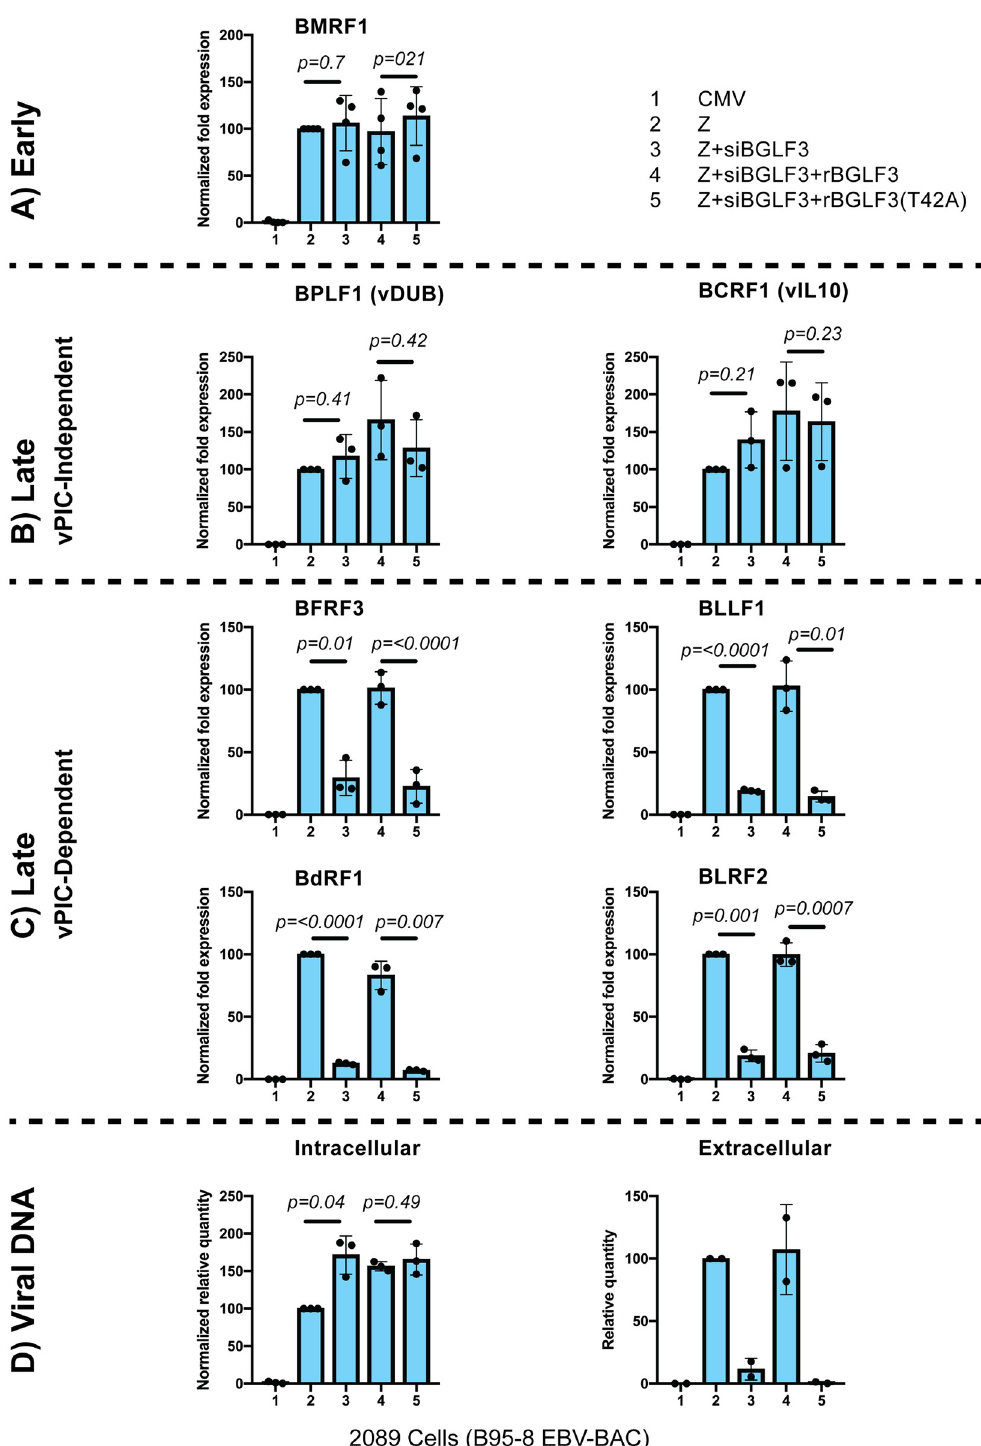
Fig 4. Mutation of threonine 42 in BGLF3 selectively abolishes transcription of late genes. Comparison of the expression of EBV lytic genes in 2089 cells expressing wild type BGLF3 or the BGLF3(T42A) mutant. RT-qPCR was used to assess the abundance of seven EBV lytic transcripts, these are: (A) early BMRF1, (B) vPIC independent late BPLF1 and BCRF1, and (C) vPIC-dependent late BFRF3, BLLF1, BdRF1, and BLRF2. (D) the amount of intracellular and extracellular viral DNA. CMV, control empty vector; Z, ZEBRA; siBGLF3, siRNA to BGLF3; rBGLF3, siBGLF3-resistant BGLF3, and rBGLF3(T42A), siBGLF3-resistant BGLF3(T42A). Each dot represents a biological replicate.